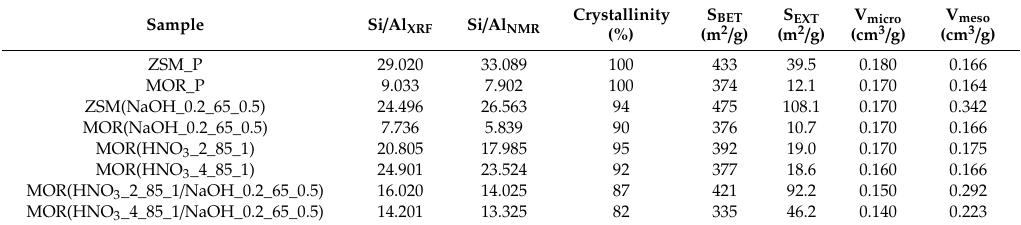
Table 3. Chemical and textural parameters of the studied materials. Sample Si / Al XRF Si / Al